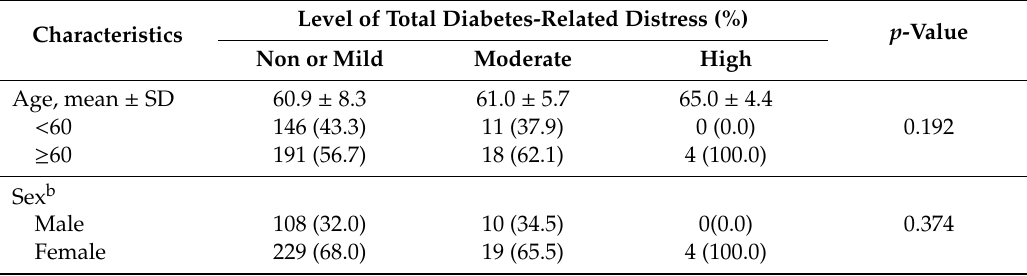
Table 3. Sociodemographic of respondents and level of diabetes distress (n =